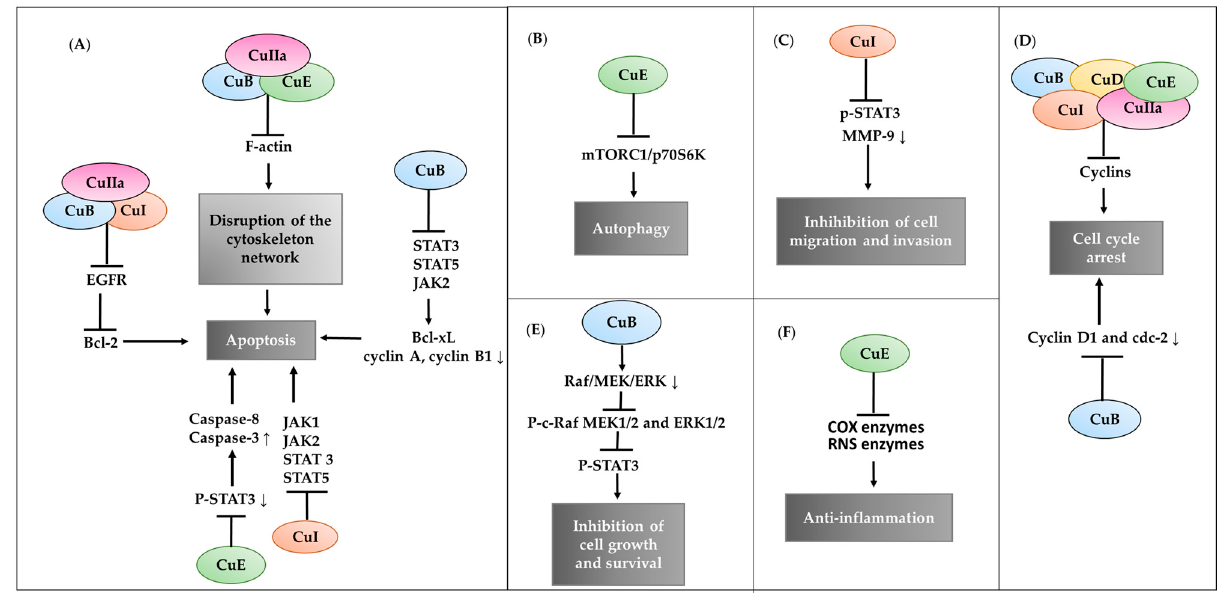
Figure 3. Most important biological action mechanisms of CuB, CuD, CuE, CuI, and CuIIa, where cucurbitacins have the following effects: ( A ) apoptotic, ( B ) autophagic, ( C ) cell migration and invasion, ( D ) cell cycle arrest, ( E ) inhibition of cell growth and survival, and ( F ) anti-inflammatory. In this context, it has been found that CuB inhibits the epidermal growth factor receptor (EGFR), prevents the growth of pancreatic cancer cells, and produces apoptosis through the negative regulation of anti-apoptotic proteins such as Bcl-2 and the increase in the amount of the proapoptotic protein Bim [44] (Figure 3A). CuE has been found to significantly affect apoptosis in bladder cancer through a decrease in the phospho-signal